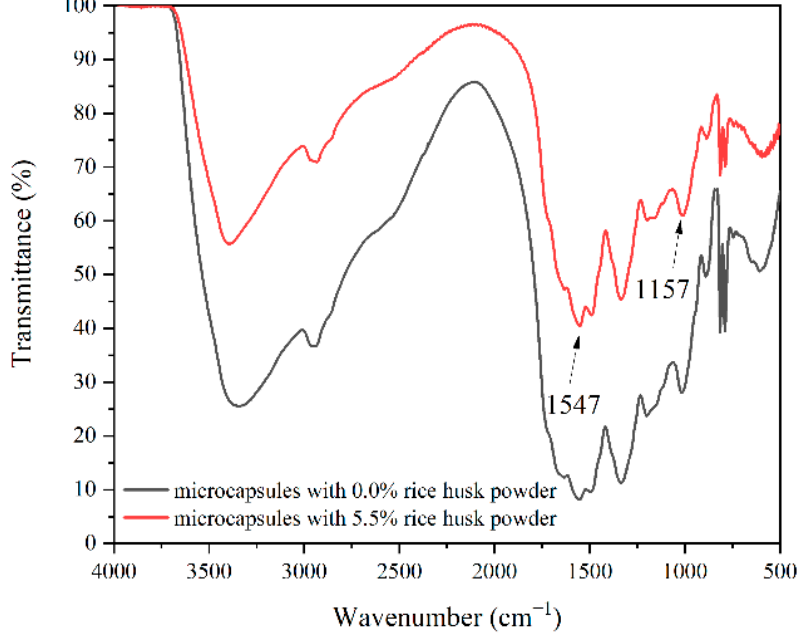
Figure 2. Infrared spectrum of microcapsules with and without rice husk powder.